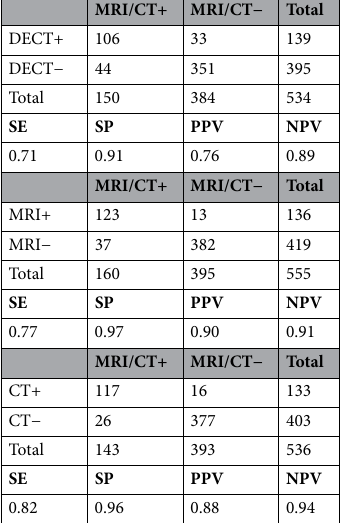
MRI+ MRI− Total MRI+ MRI− Total DECT+ 45 42 87 CT+ 37 SE SP PPV NPV SE SP PPV NPV